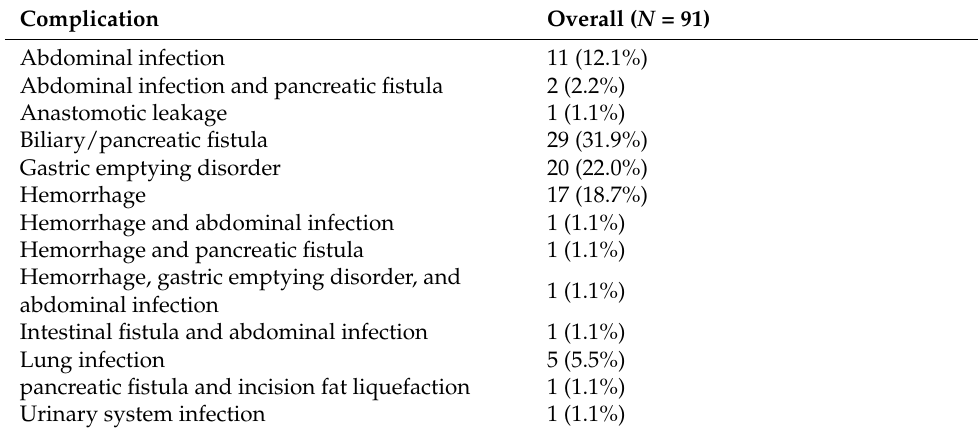
Table 2. The details of postoperative complications for 91 AC patients undergoing curative pancreatoduodenectomy.